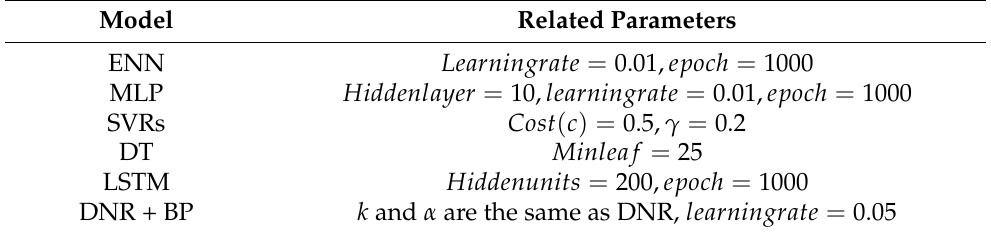
Table 4. Parameter settings of the prediction models for each air quality